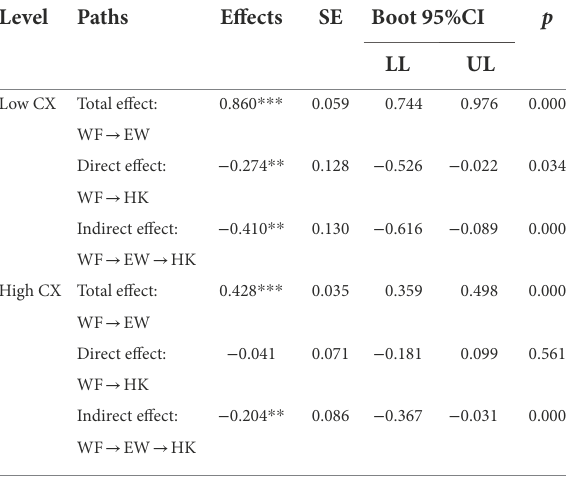
TABLE 6 The moderated mediating